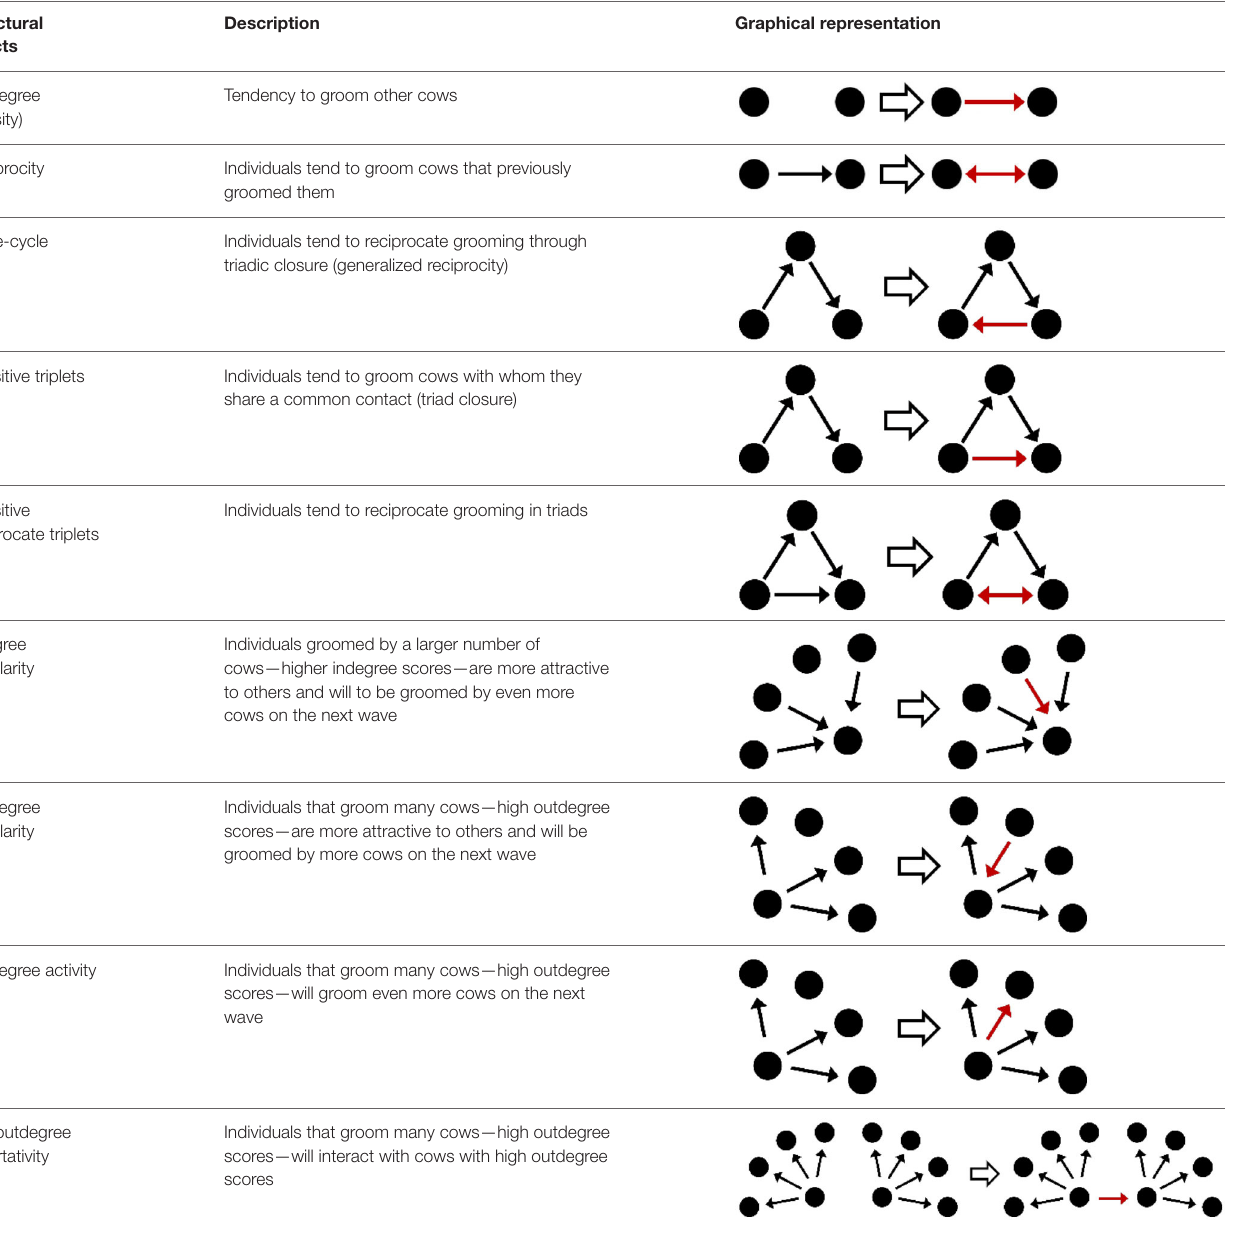
TABLE 2 | Description of the structural effects tested in the